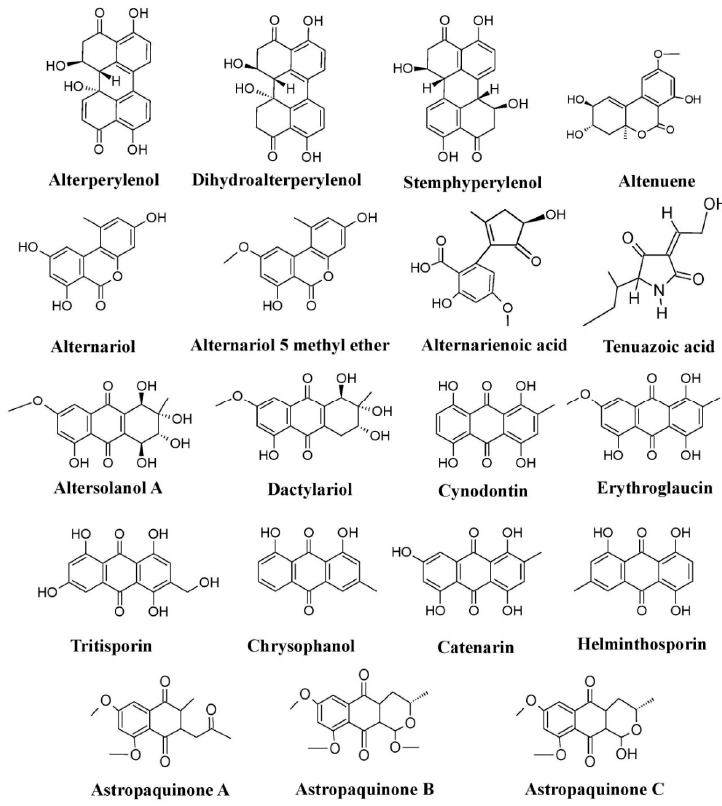
Figure 6. Pigments produced by members of the fungal family Pleosporaceae (species of Alternaria , Curvularia , Astrosphaeriella , and Pyrenophora ), re-drawn from [25,76–78]. Microorganisms 2019 , 7 , x FOR PEER REVIEW